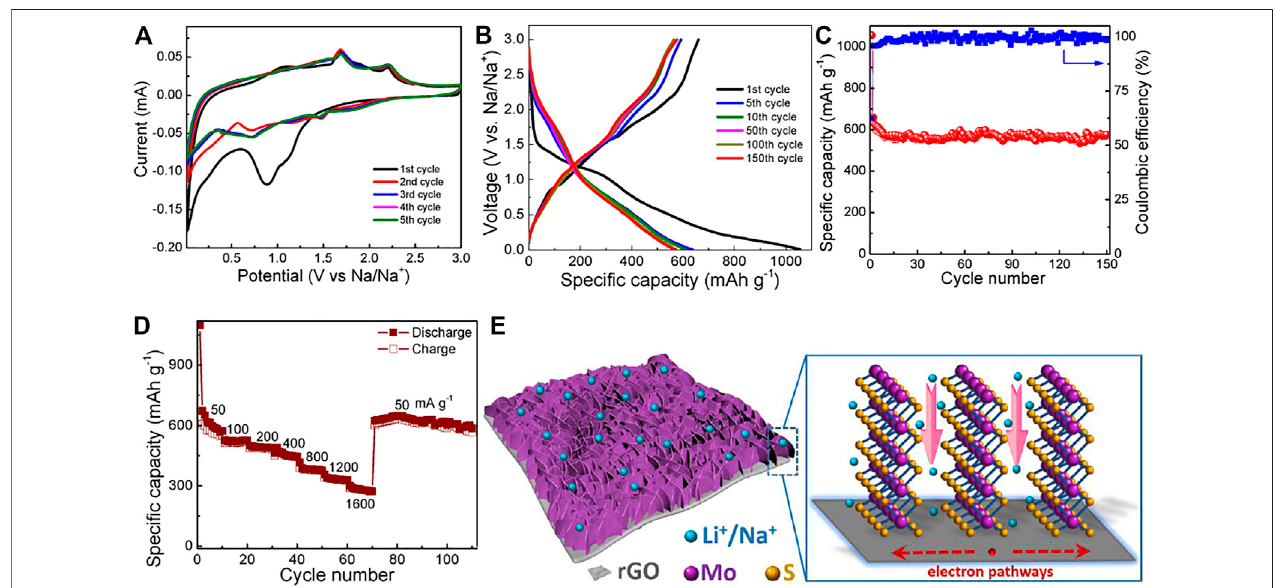
FIGURE 6 | (A) CV, (B) charge/discharge curves, (C) cycling performance, and (D) rate capability of the MoS 2 @rGO electrode for SIBs. (E) Energy storage characteristics of